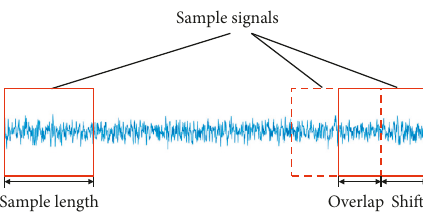
Figure 11: Data sampling in MFPT. Table 4: Dataset description in MFPT.